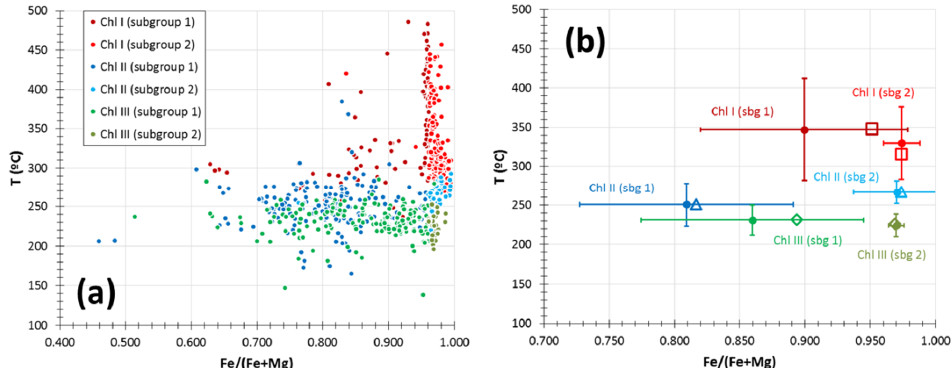
Figure 15. ( a ) Fe/(Fe + Mg) ratios vs. temperature estimates for chlorite formation based on the six endmember components model that assumes an ideal mixing on sites with ordered cationic distribution [204]. ( b ) Mean (and standard error bars) and median temperature values for each subgroup of analyses representing the three chlorite generations identified.